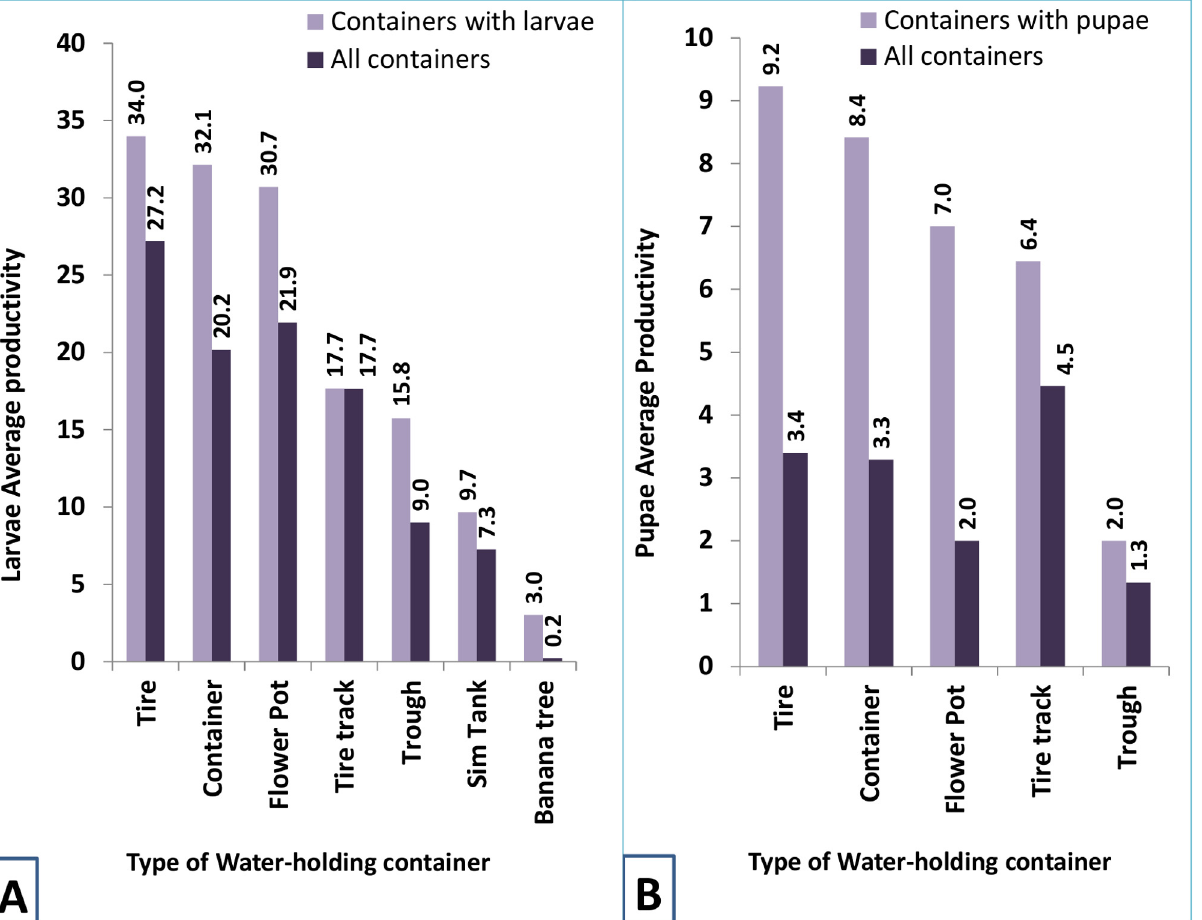
Fig 2. Average productivity of the mosquito larvae (A) and pupae (B) per type of water-holding container separating those found with larvae/pupae and all